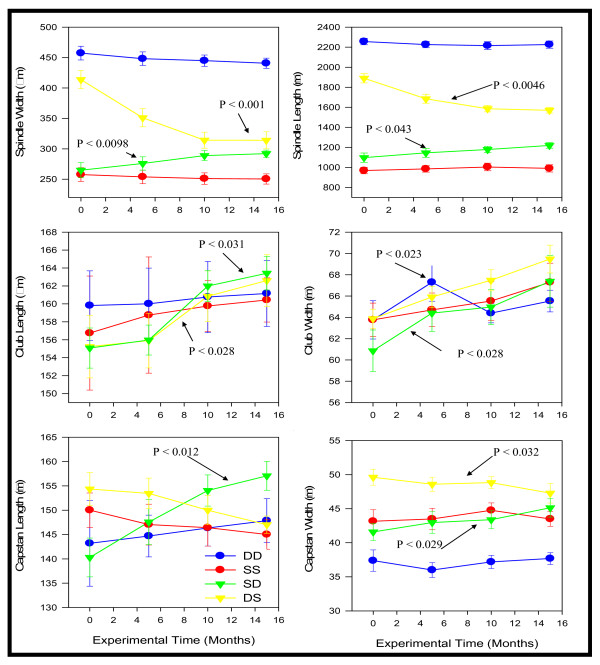
Reaction norms of morphological traits through time in transplanted colonies. Spindle changes are more drastic than club and capstans. Population codes are SS: Shallow to shallow; DD: Deep to deep for residents and SD: Shallow to deep and DS: Deep to shallow for reciprocal transplants. Values are given as mean value ± 1 standard deviation.